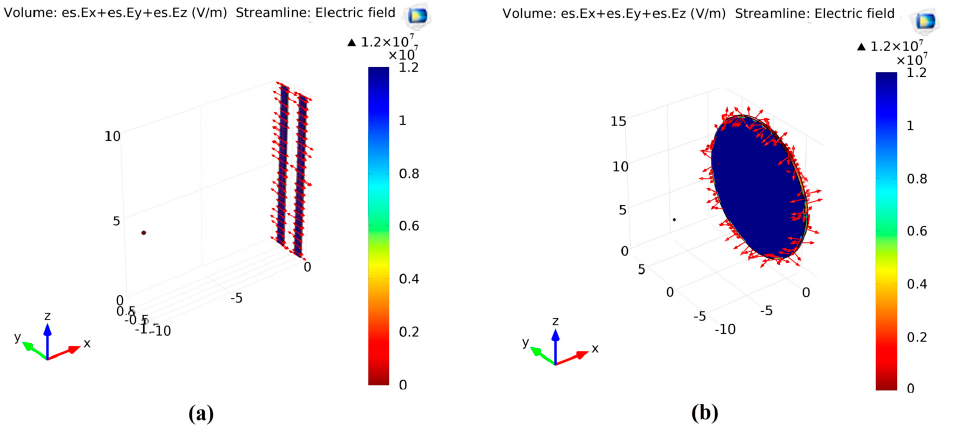
Figure 2. Electric field distribution for ( a ) 2 bars collector and ( b ) Conventional collector.